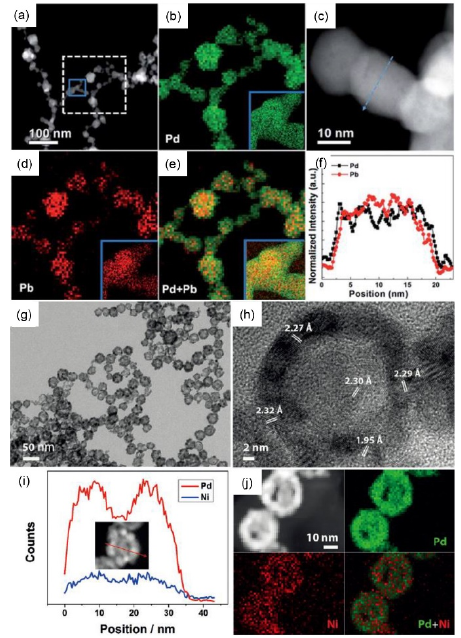
Figure 2. ( a , b , d , e ) scanning transmission electron microscopy- electron energy loss spectroscopy ( STEM-EELS ) elemental mapping and line scan. ( c , f ) results of the Pd 3 Pb 1 @Pd aerogel [35]. Copyright